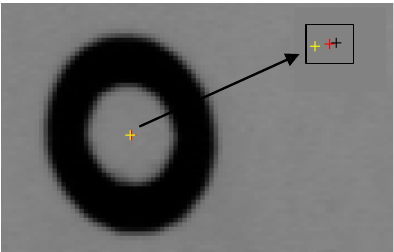
Figure 6. Circle centre projection result obtained by the concentric circle compensation method (the enlarged sub-image is framed at right top).